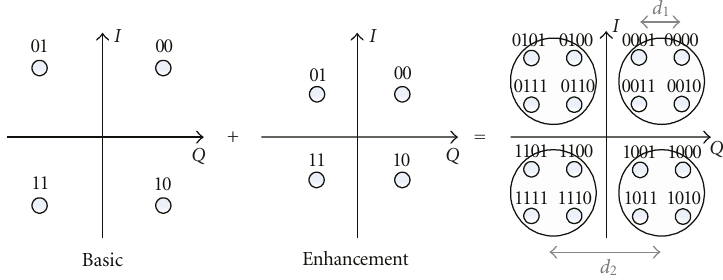
Figure 6: Signal constellation for 16-QAM hierarchical modulation.